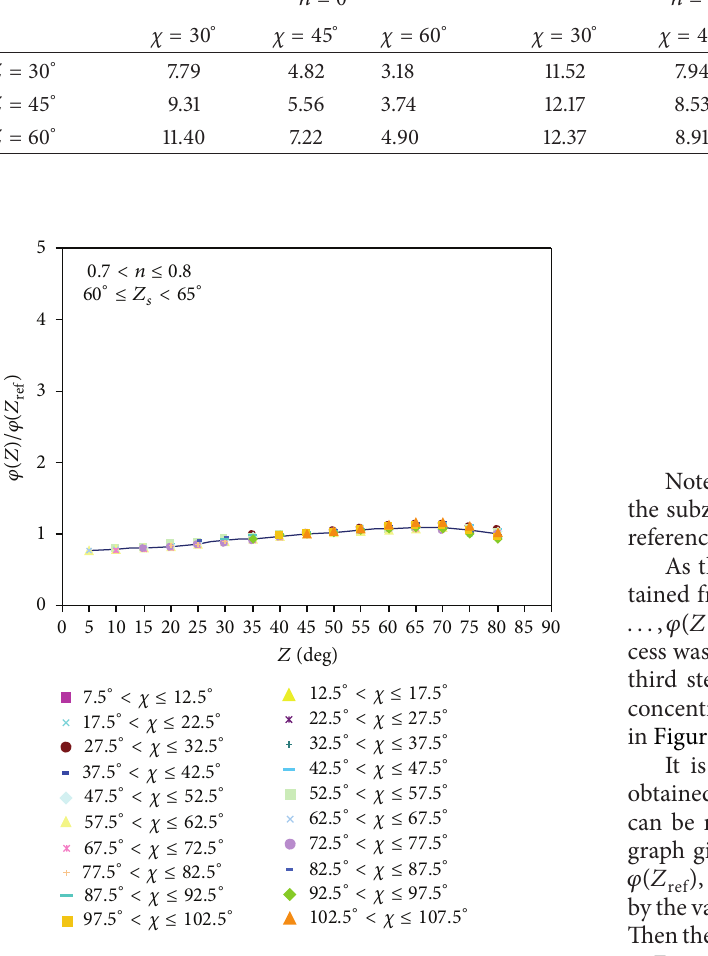
) against the sky ref